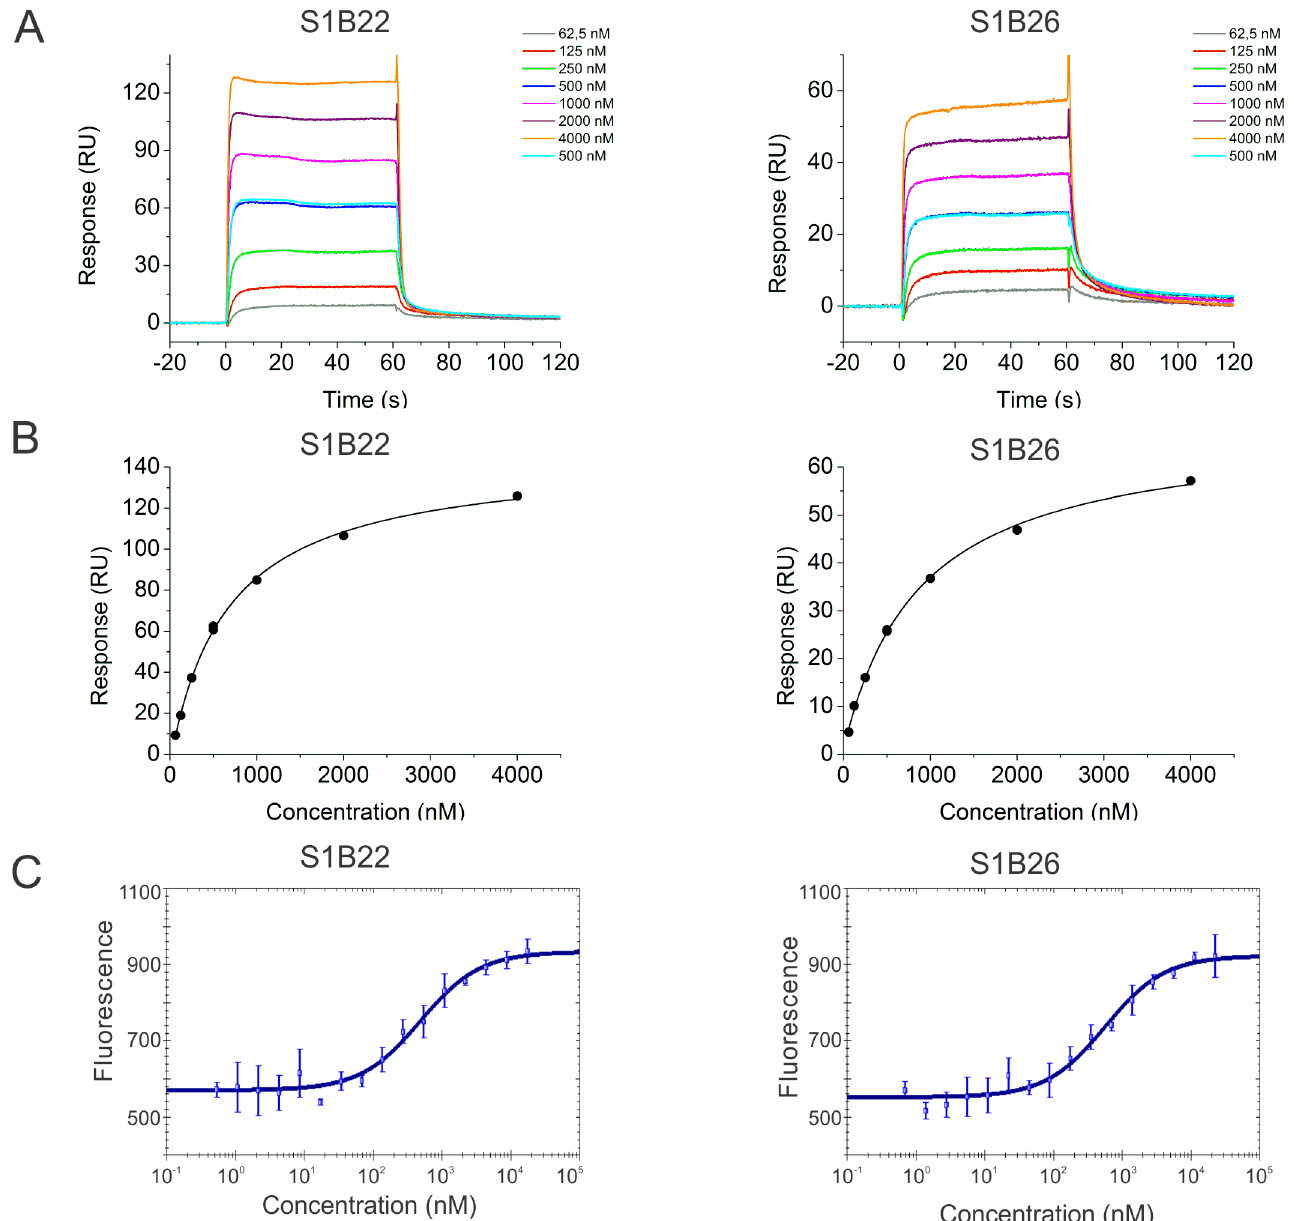
Fig 5. Determination of binding affinity of selected S1B variants to recombinant Stx1B by SPR analysis (A, B) and MST (C). (A) Recombinant Stx1B at seven different concentrations was injected over the chip surface with immobilized H6-S1B22-TolA-Avi or H6-S1B26-TolA-Avi. (B) Steady state response (obtained in (A)) was plotted against Stx1B concentration and Steady State Affinity model was applied to calculate the affinity constant. (C) Sixteen serial dilution concentrations of H6-S1B22-TolA-Avi or H6-S1B26-TolA-Avi were mixed with fluorescently labelled Stx1B at 5 nM final concentration. Fluorescence change K d fit in NanoTemper software was used to calculate K d . Error bars denote standard